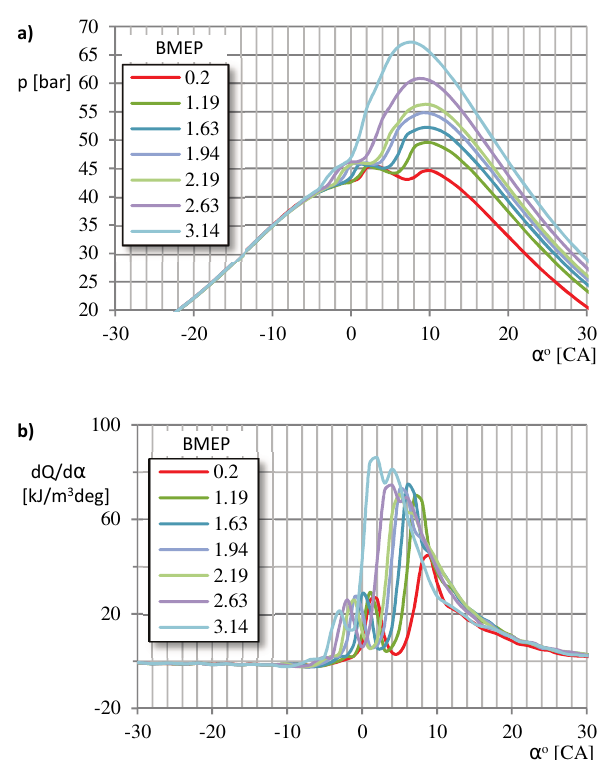
Fig. 3. Pressure diagrams (a) and heat release diagrams (b) for different engine load and constant engine speed (1500 rpm) for fueling with stan- dard injection timing of Jet A-1 fuel